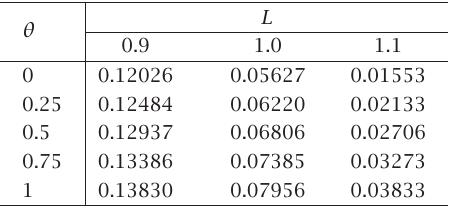
Table 4.2 . CVaR for bivariate portfolio insurance.